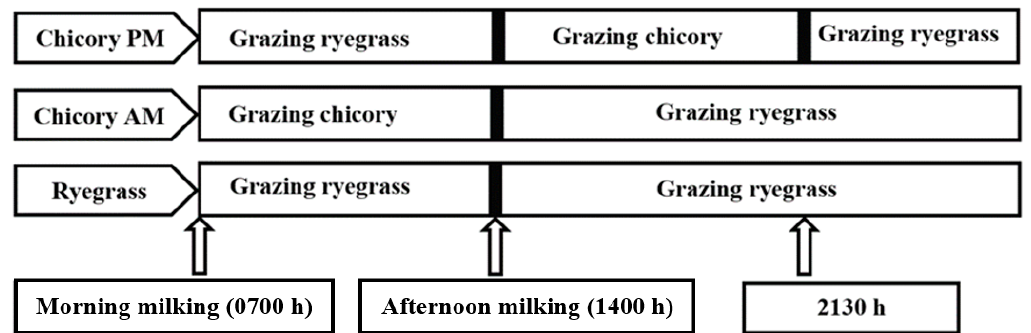
Figure 1. Management regimes during the experiment. Control cows offered ryegrass only (RGWC),